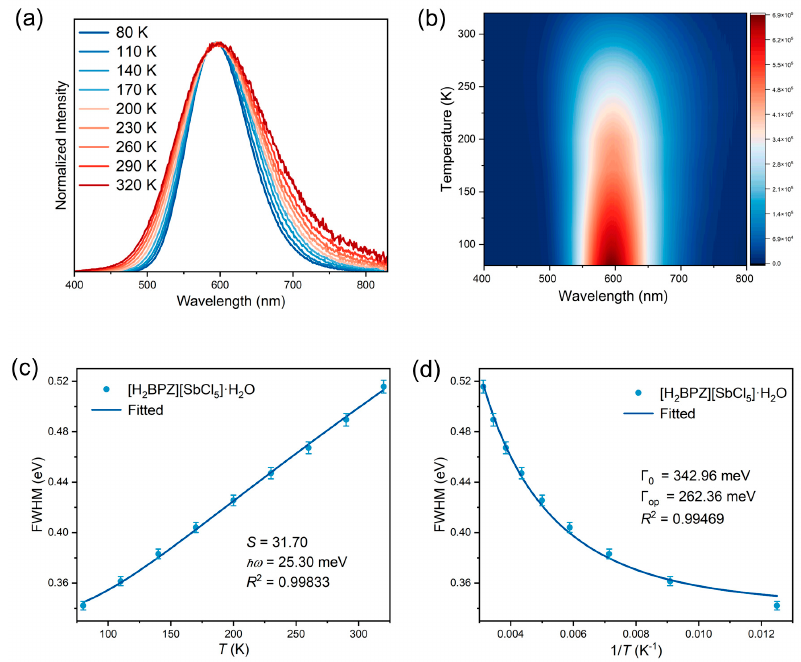
Figure 3. Temperature-dependent PL spectra and fitted physical parameters. Temperature-dependent PL spectra ( a ) and contour map ( b ) of [H 2 BPZ][SbCl 5 ]•H 2 O under the excitation of 320 nm. ( c ) Full width at half maximum (FWHM) versus temperature ( T ) fitted by Equation (3). ( d ) FWHM versus 1/ T fitted by Equation (4).